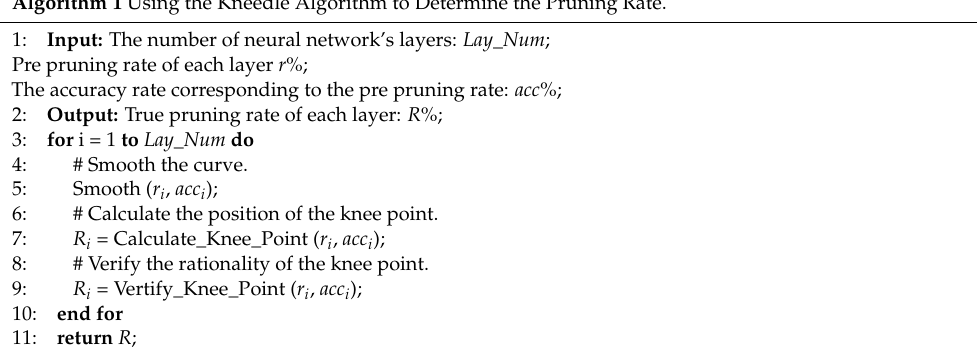
Algorithm 1 Using the Kneedle Algorithm to Determine the Pruning Rate.